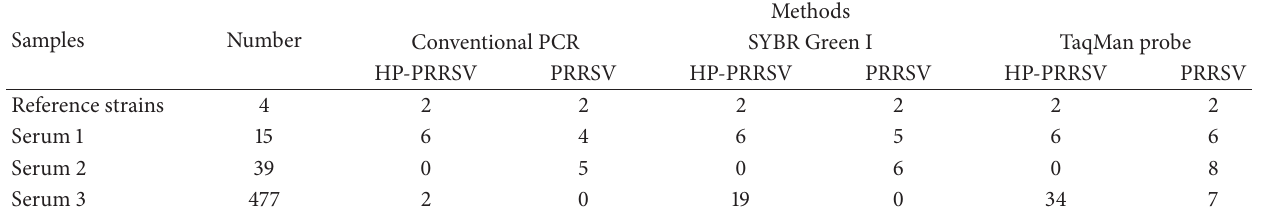
Table 3: Detection results of samples by conventional and real-time PCR.